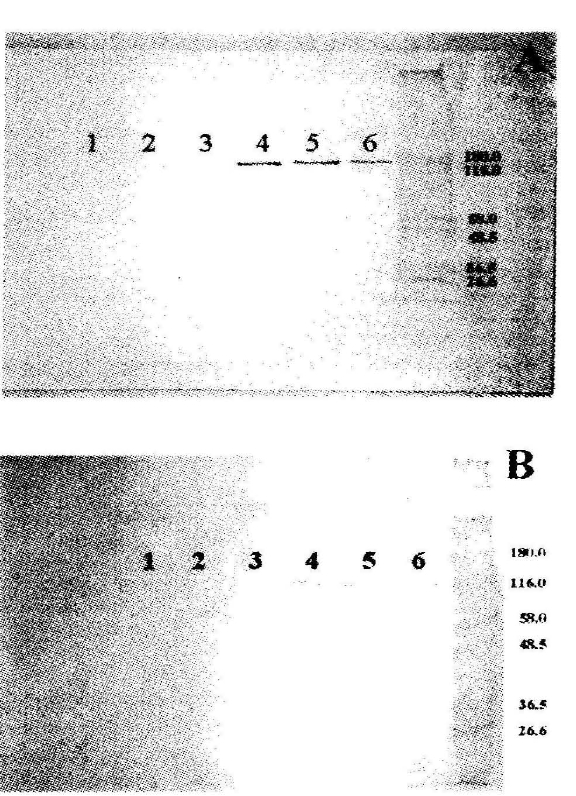
Figure 2: Western blot detection of inducible mtnc oxide synthase protein in cytosolic extracts of OVCAR-3 (Panel A) and HOC-7 (Panel B) cells treat ed for 24 h with: neopterin at concentrations of 100 11M (lane 2) and 1000 JlM (lane 3), a cytokine mixture (lane 4), or with the combination of ncopterin and the cytokine mixture (lane 5 and lane 6), respectively.